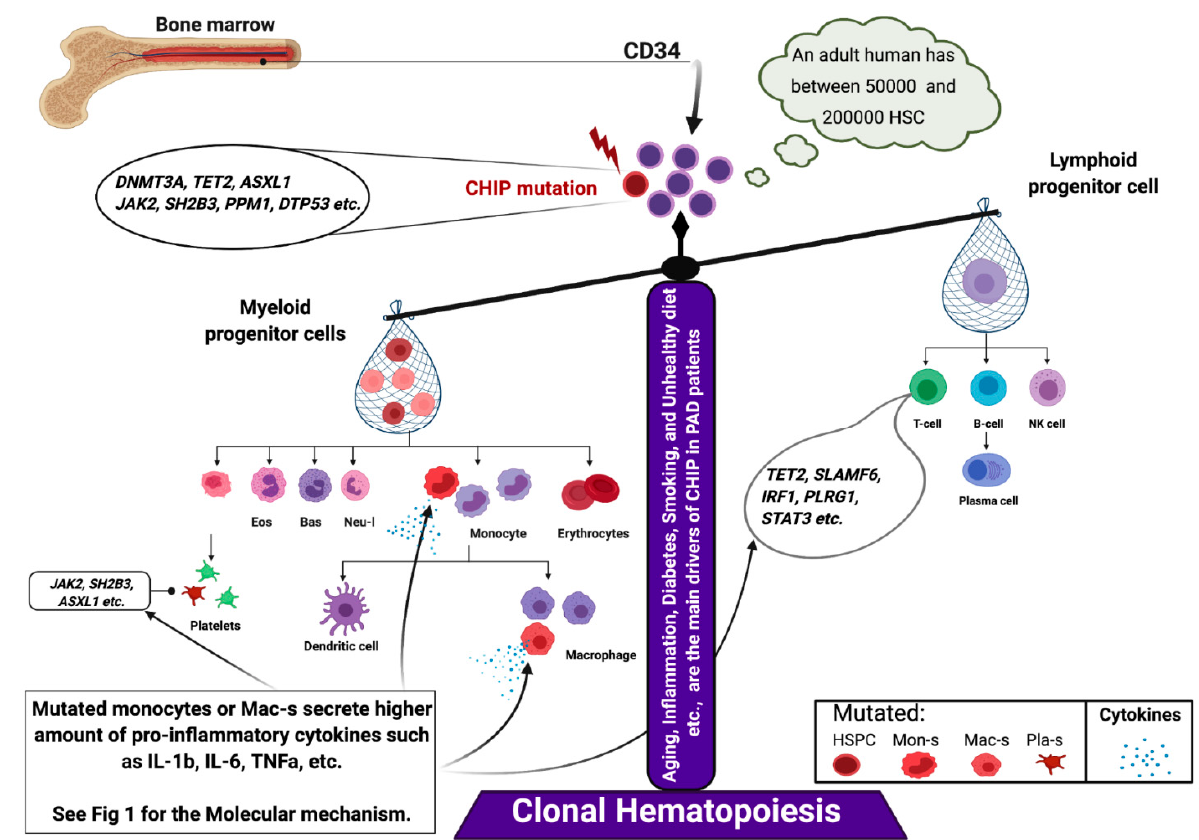
Figure 4. CHIP-induced hematopoiesis. Abbreviation: CHIP, clonal hematopoiesis of indeterminate potential.